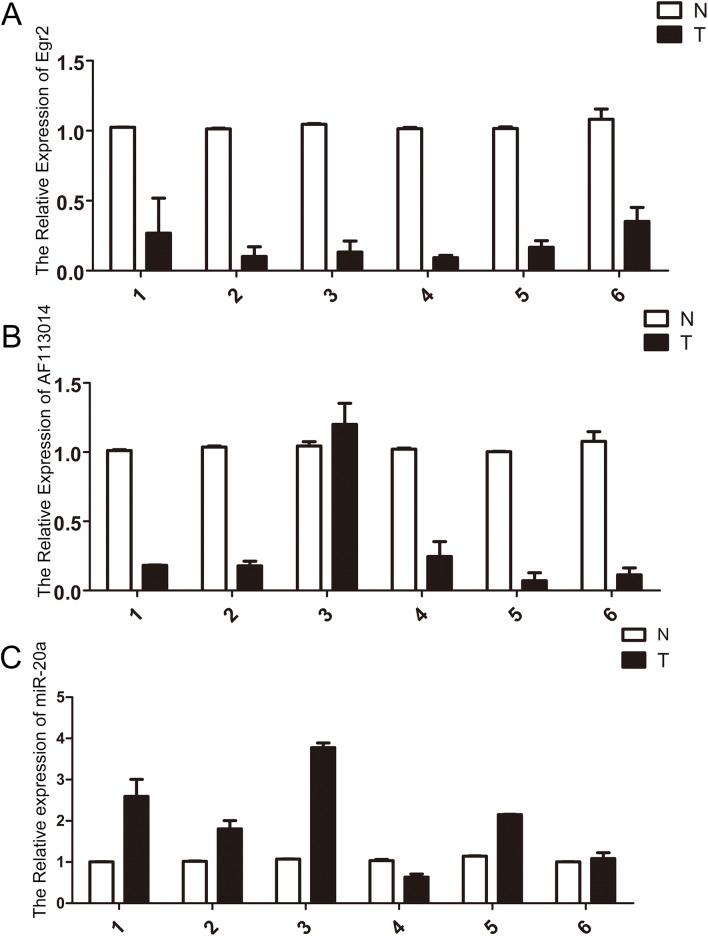
The expression of miR-20a/LncRNA-AF113014/Egr2 in HCC.The expressions of Egr2, LncRNA-AF113014 and miR-20a in HCC tissues were analyzed with qPCR.